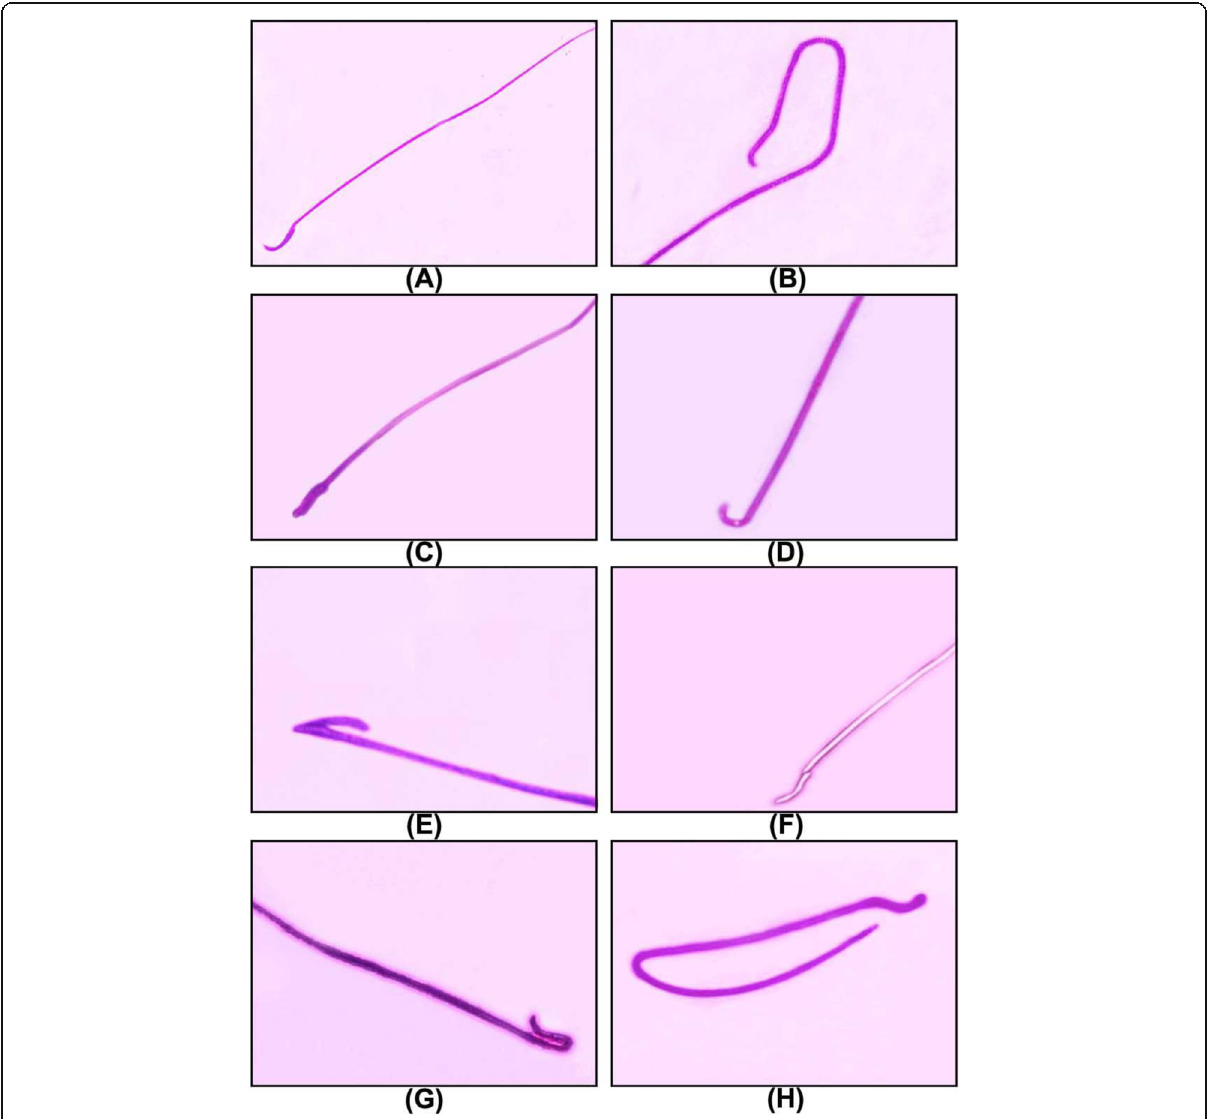
Fig. 3 Photomicrograph of different sperm abnormalities of rats fed with grilled tilapia fish showing a normal sperm, b quasi-normal head, c amorphous head, d vacuolated head, e detached head, f hookless head, g bent with projection filament and tail, and h big head with coiled tail (E&N ×